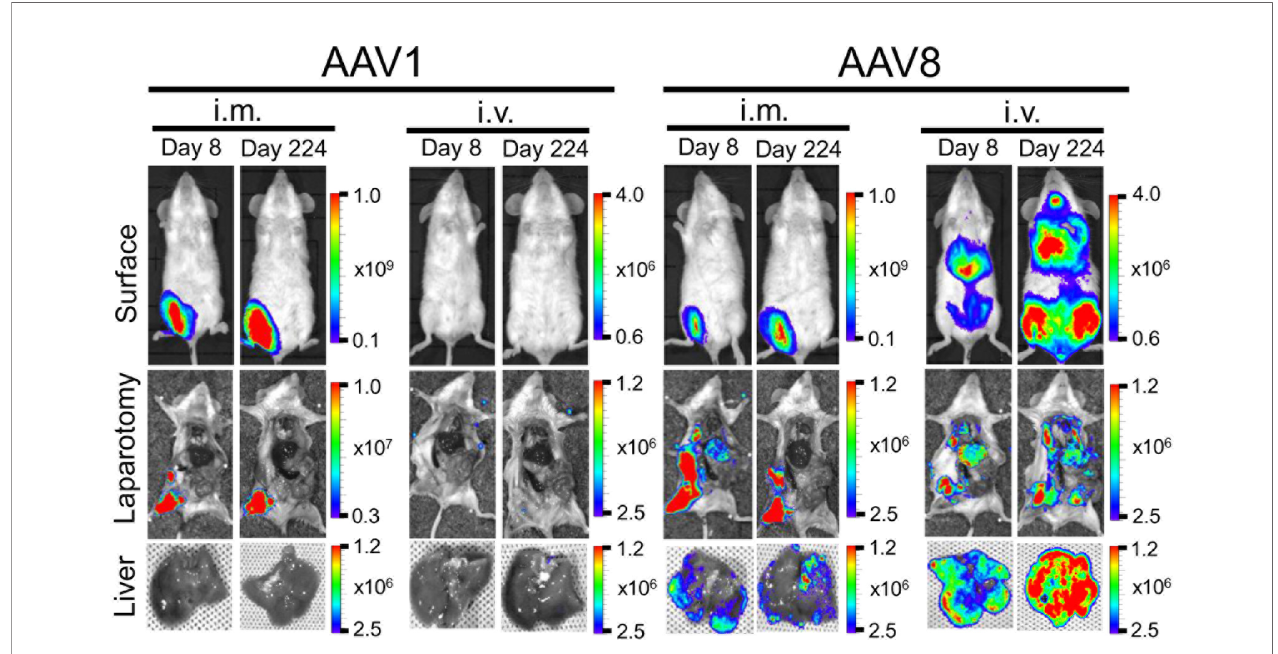
FIGURE 2 | Comparison of luciferase expression in the liver between AAV1-Luc and AAV8-Luc. Luciferase expression in the liver on day 8 or day 224 was detected using the IVIS Lumina LT Series III in vivo imaging system. AAV1-Luc or AAV8-Luc was injected into the right medial thigh muscles or tail veins of mice (n = 2; 1.0 × 10 11 vg/mouse) on day 0. On days 8 and 224, mice were dissected 15 min after D-luciferin was administered i.p. and luciferase expression in the liver was measured. The heatmap images in the mice represent the total fl ux of photons (p/s/cm 2 ) in the area of interest. Rainbow scale ranges are expressed in radiance (p/ s/cm 2 /sr). The mean total fl ux of photons is shown as the region of interest on days 8 and 224 after AAV-Luc administration with the indicated serotype and